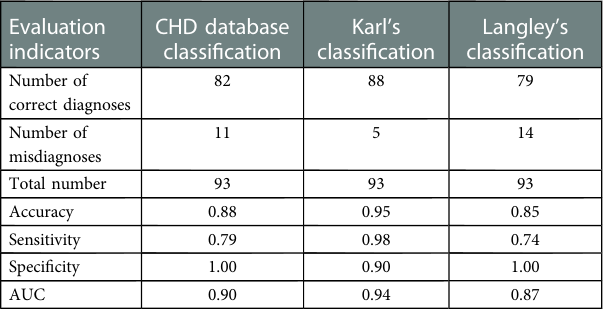
TABLE 3 Comparison of diagnostic criteria based on intelligent measurement.